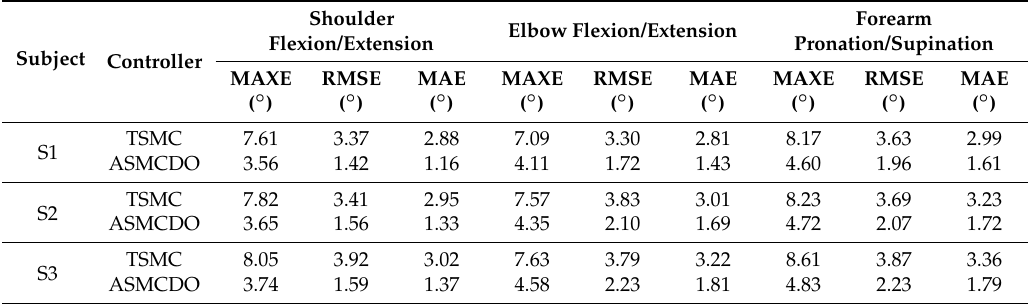
Figure 9. The comparison results of the trajectory tracking experiments for forearm pronation/supination movement. ( a ) Time histories of desired displacement and actual displacement. ( b ) Comparison between desired displacement and actual displacement. ( c ) The tracking error of different controllers. Table 3. Statistical results of the trajectory tracking experiments with different control strategies and different volunteers.